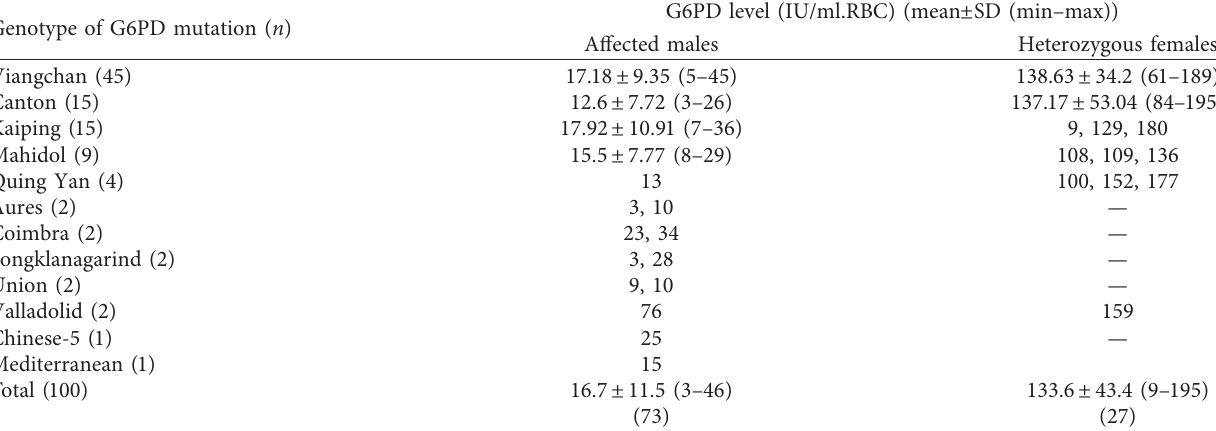
Table 3: Genotype of G6PD mutations and G6PD levels in 73 affected males and 27 heterozygous females. Genotype of G6PD mutation ( n )